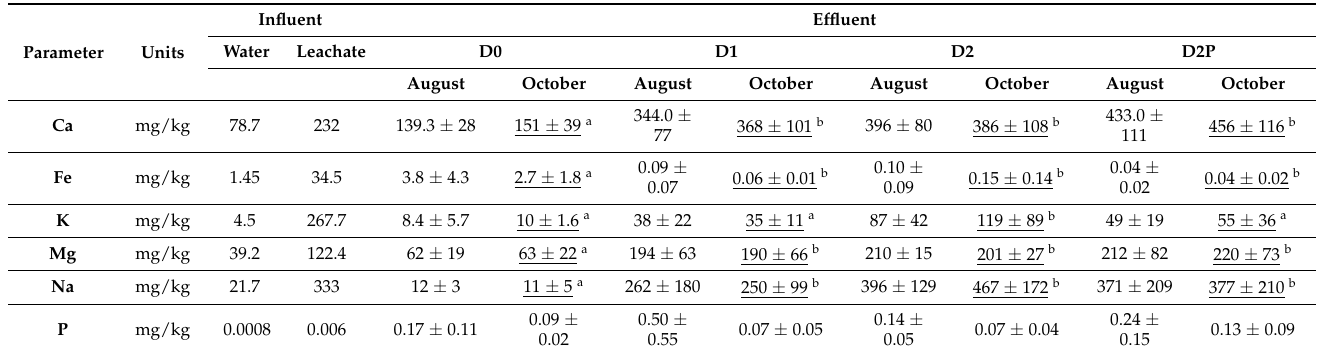
Table 3. Variation in the seasonal concentration of macronutrients in the porewater of plots irrigated with groundwater (D0) and leachate (D1, D2, and D2P) in 2020.